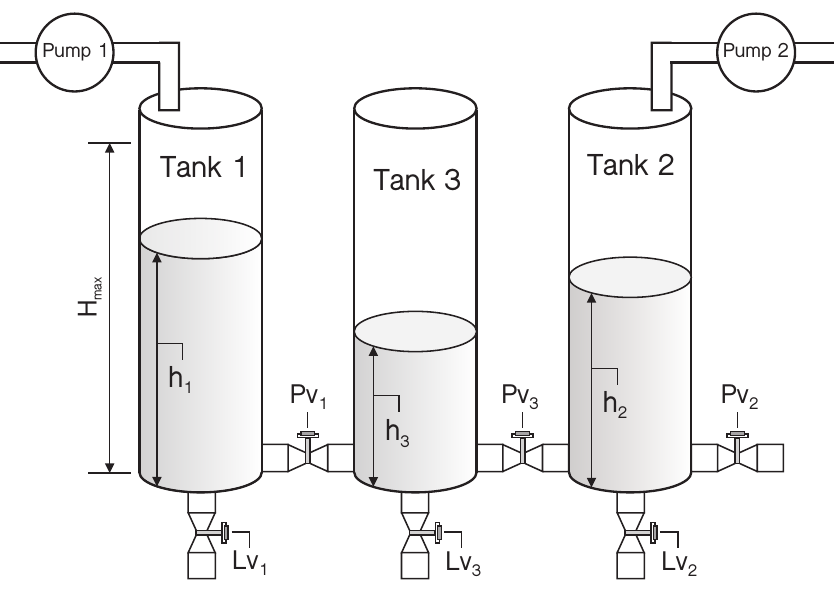
Figure 3. Structure of the three-tank